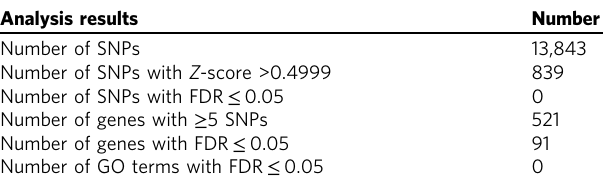
Table 2 SNPs, genes and GO terms found to correlate